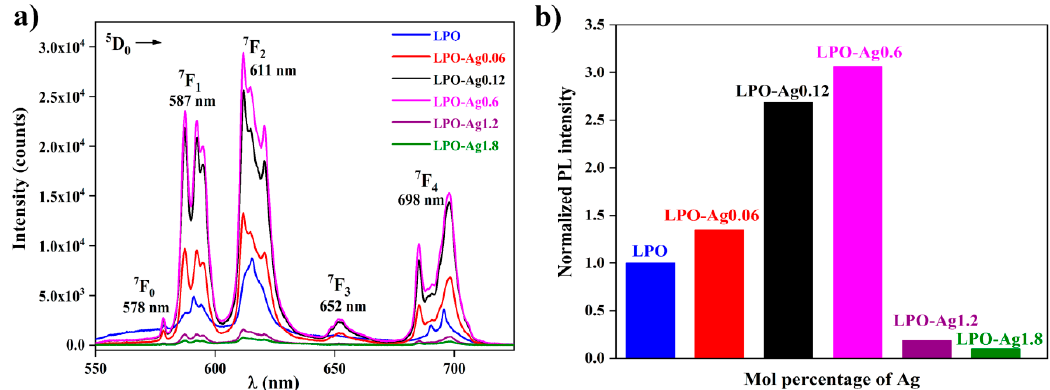
Figure 6. ( a ) Photoluminescence emission spectra of the LPO and Ag / La 0.95 Eu 0.05 PO 4 nanostructures; ( b ) the normalized photoluminescent (PL) intensity as a function of the Ag NP concentration in the LPO and Ag / La 0.95 Eu 0.05 PO 4 nanostructures showing the maximum enhancement factor ~3.